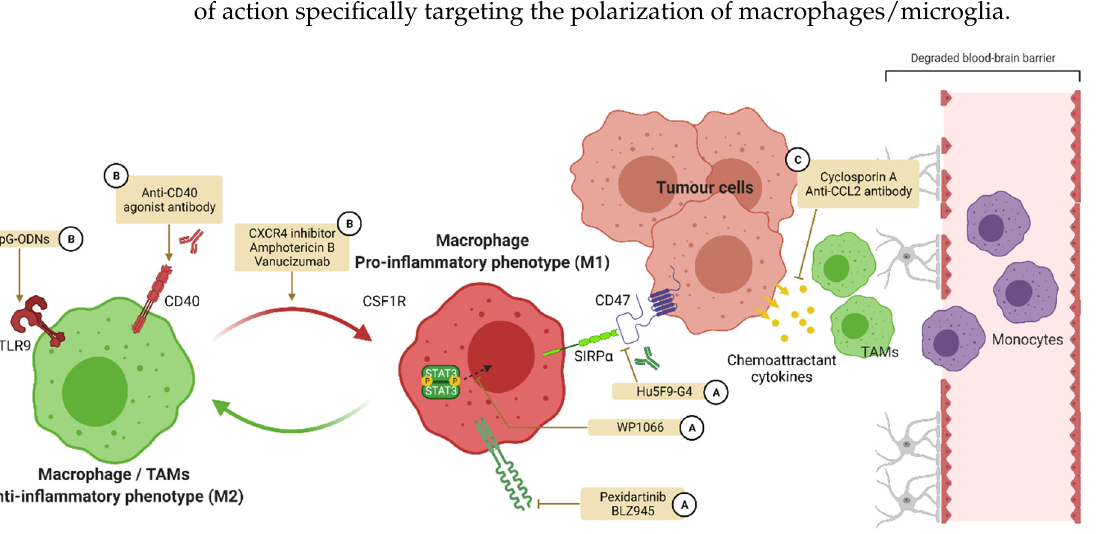
Figure 5. Targeting macrophage polarization in glioblastoma. In GBM, macrophages adopt a M2-like phenotype inhibiting inflammation and anti-tumoral immunity. A strategy for the reactivation of this immunity is to target the polarization of macrophages in order to promote M1 activation. A first strategy is to inhibit targets promoting M2 polarization such as CSF1R and STAT3 or the recognition of CD47 by SIRP α ( A ). Another strategy is to activate targets favoring M1 polarization such as TLR9 and CD40 ( B ). A last strategy is to inhibit the attraction of M2 polarized TAMs from the circulation toward the CNS ( C ). CSF1R: colony-stimulating factor 1 receptor, SIRP α : signal regulatory protein α , TAMs: tumor associated macrophages, TLR: Toll-like receptor.